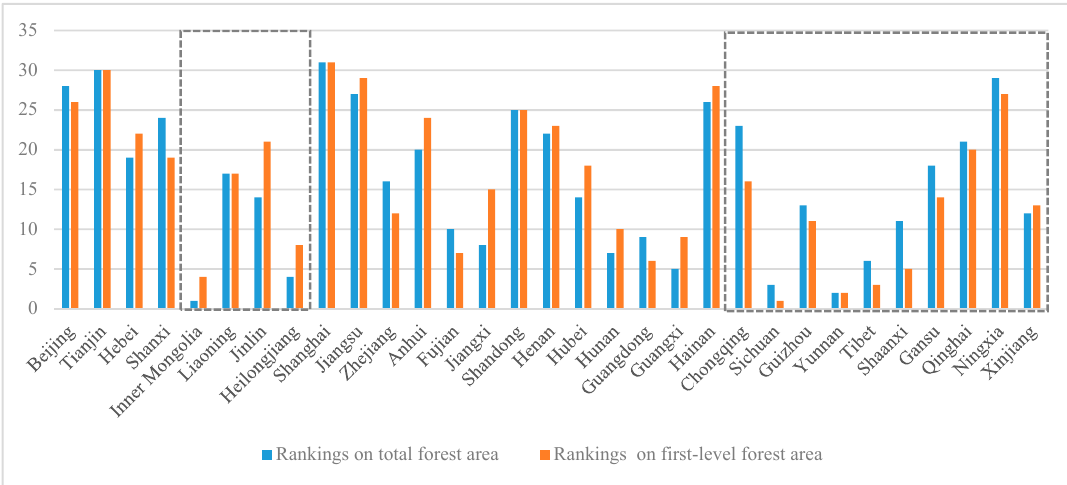
Figure 6. Rankings of the total forest area and area of L1 forest landscape in all divisions (northeast, southwest and northwest regions highlighted in dotted boxes).